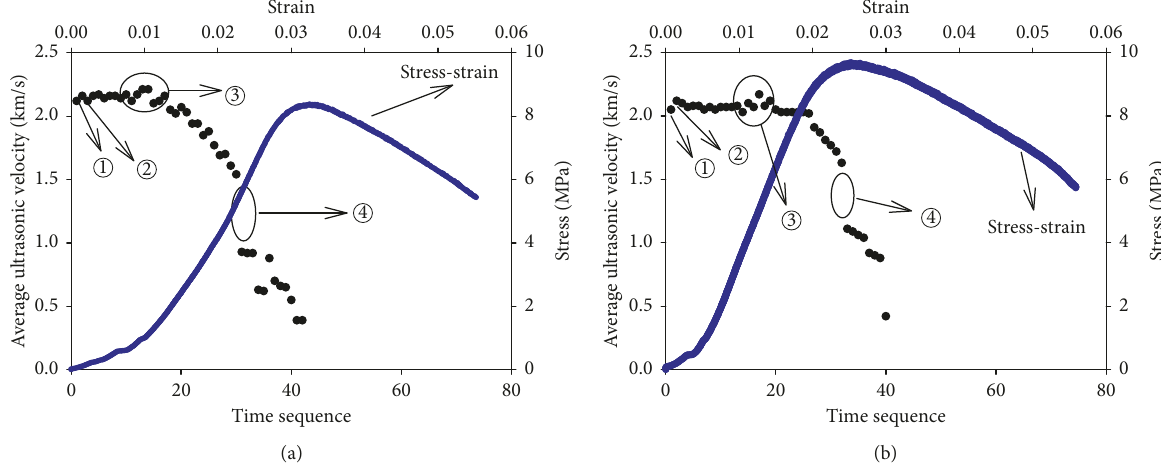
Figure 12: Variation in the average ultrasonic velocity with 30% (a) and 50% (b) waste concrete substitution under uniaxial